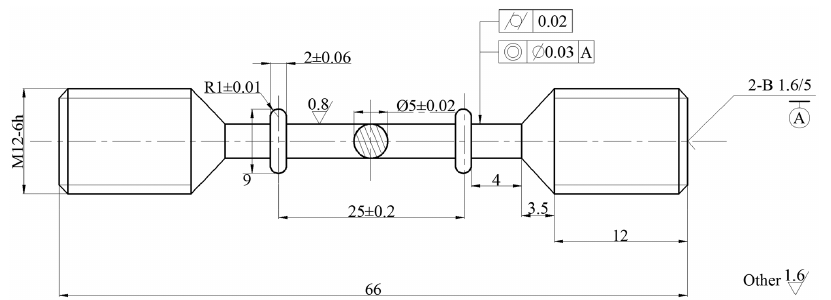
Figure 1: Geometry and dimensions (mm) of stress relaxation specimen.